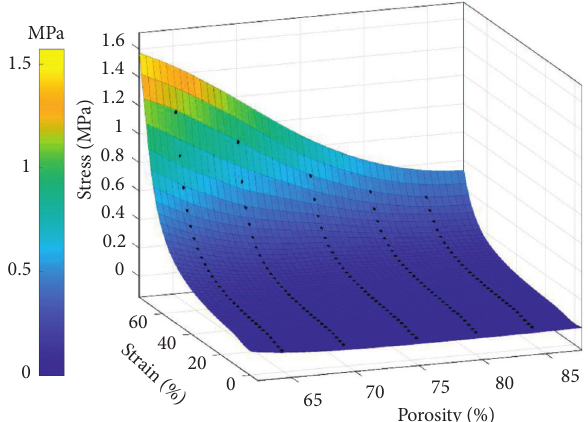
Figure 7: Surface fitting of stress-strain curves and